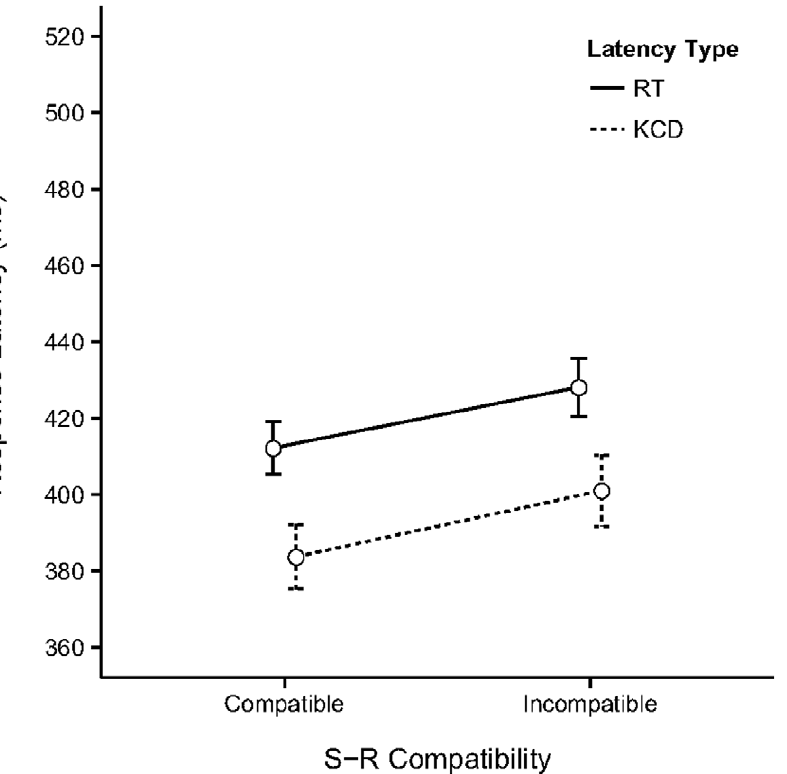
Figure 2. Results of Experiment 1. The observed means (with 95% CI) for the two types of response latency measured in Experiment 1 as a function of S-R Compatibility of the trials. The values of the means, confidence intervals and size of the Compatibility Effect (CE) are reported in Table S1.